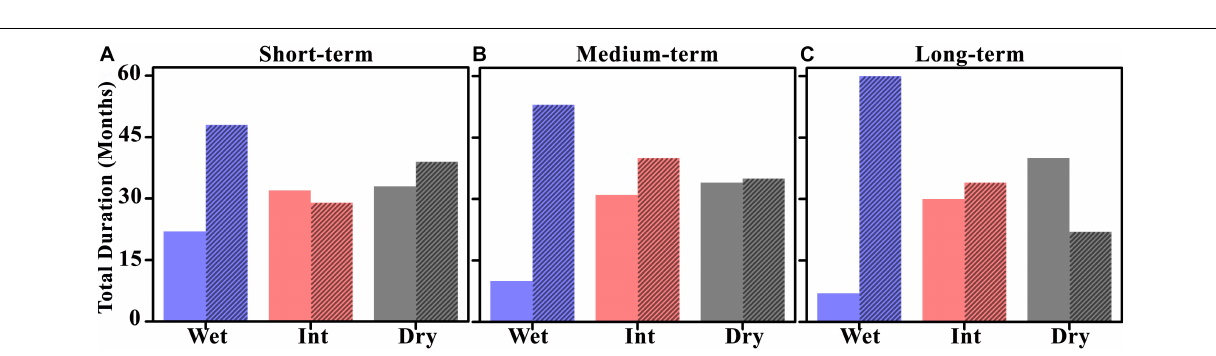
Frontiers in Earth Science |